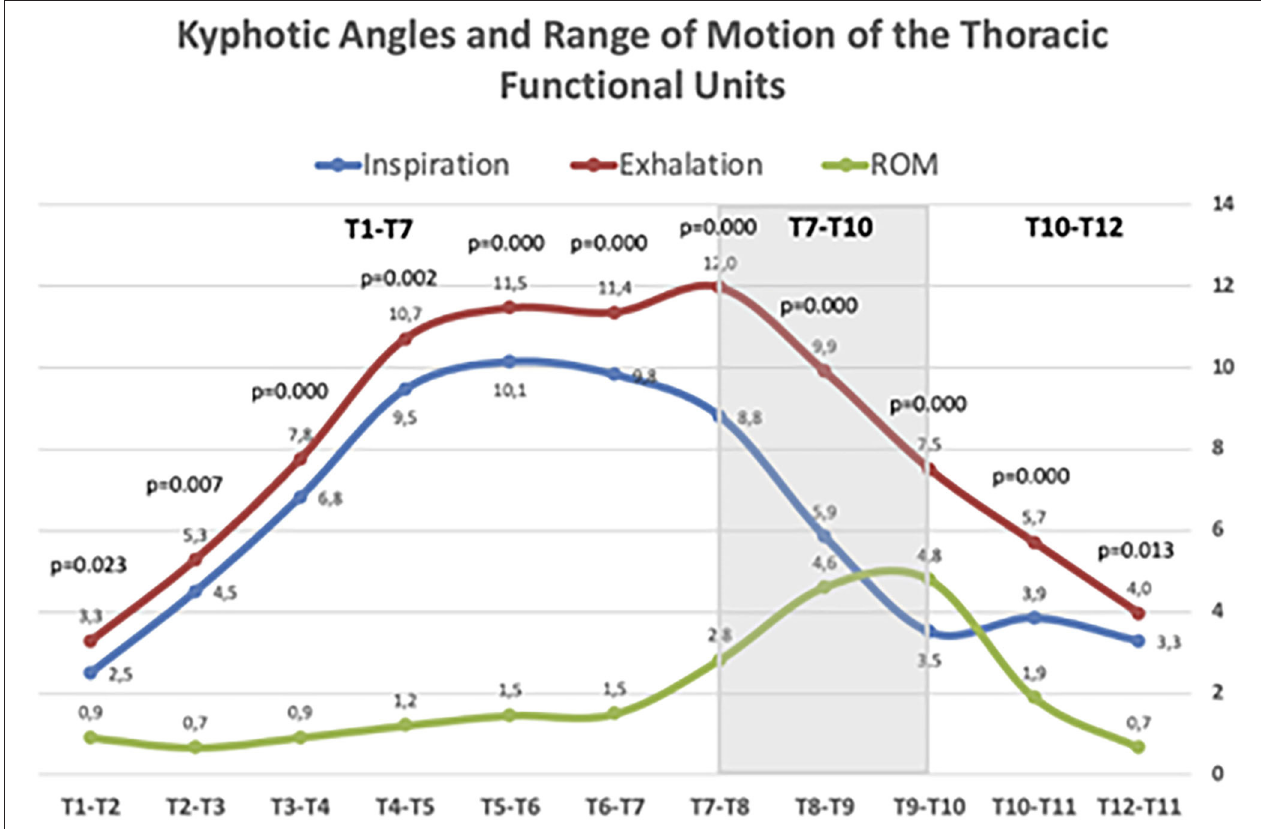
FIGURE 4 | Kyphotic angles and Range of motion (ROM) of thoracic spine segments during maximal forced inspiratory and expiratory phases. Values age given in mean Cobb angle. Statistically significant differences between inspiratory and expiratory angles are given for each segment according to the Wilcoxon rank